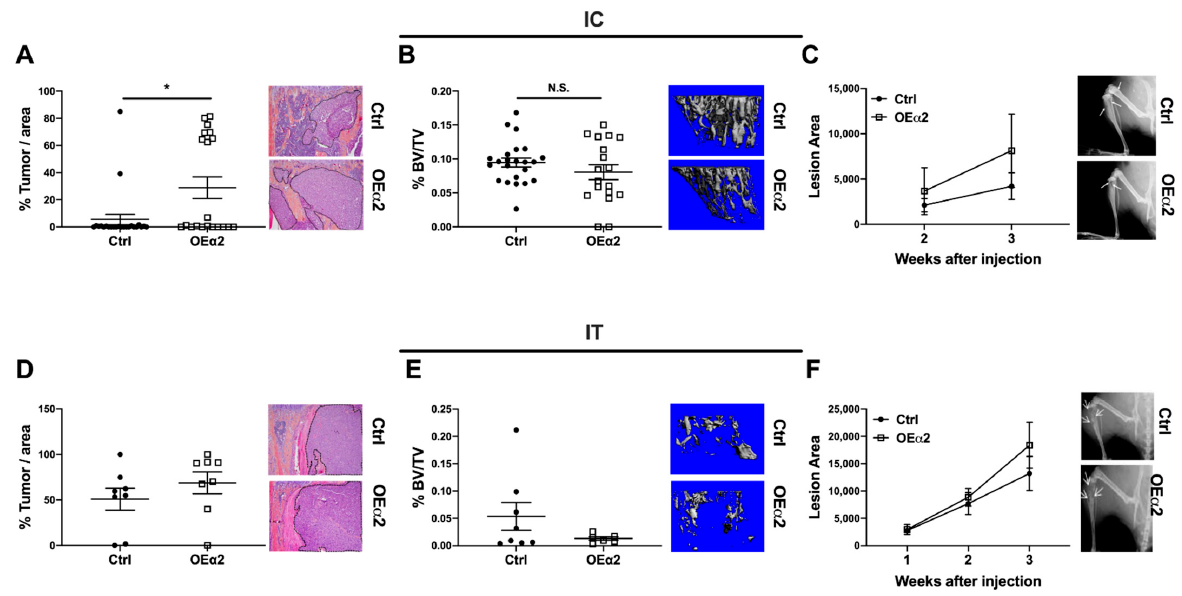
Figure 3. ( A – C ) Four–six-week-old athymic nude mice were injected via intracardiac (IC) injection with 1 × 10 5 MDA-Ctrl or MDA-OE α 2 cells. ( A ) H&E staining revealed increased percentage of tumor cells in the tibias of mice injected with MDA-OE α 2 cells compared to mice injected with MDA-Ctrl cells. ( B ) μ CT analysis and ( C ) X-ray analysis show no change in bone volume and lesion area. N = 12 mice per group, 2 bones analyzed per mouse. IC mice were sacrificed 30 days post tumor inoculation. Mann–Whitney test. * p < 0.05. ( D – F ) Four–six-week-old athymic nude mice were injected via intratibial (IT) injection with 1 × 10 5 MDA-Ctrl or MDA-OE α 2cells. ( D ) Histomorphometry reveals no difference in tumor area between MDA-OE α 2 and MDA-Ctrl injected mice. ( E ) μ CT analysis shows no difference in bone volume, and ( F ) X-ray analysis shows no difference in the lesion area. N = 8 per group. IT mice were sacrificed 21 days post tumor inoculation. Mann–Whitney test.